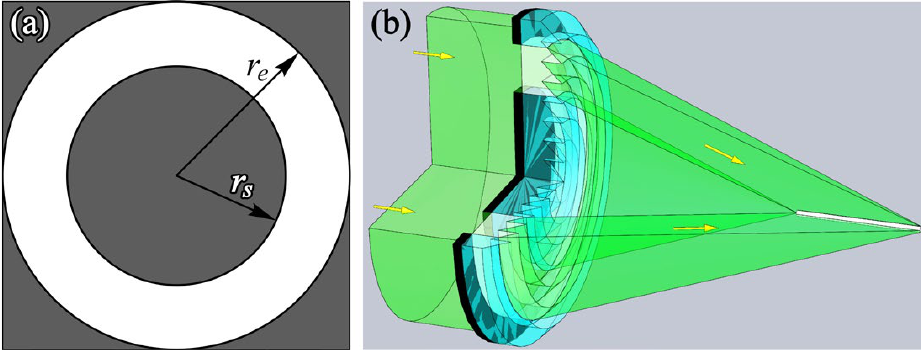
Figure 1. ( a ) View of the annular slot. ( b ) Geometric-optical illustration of the formation of a light segment on the optical axis.